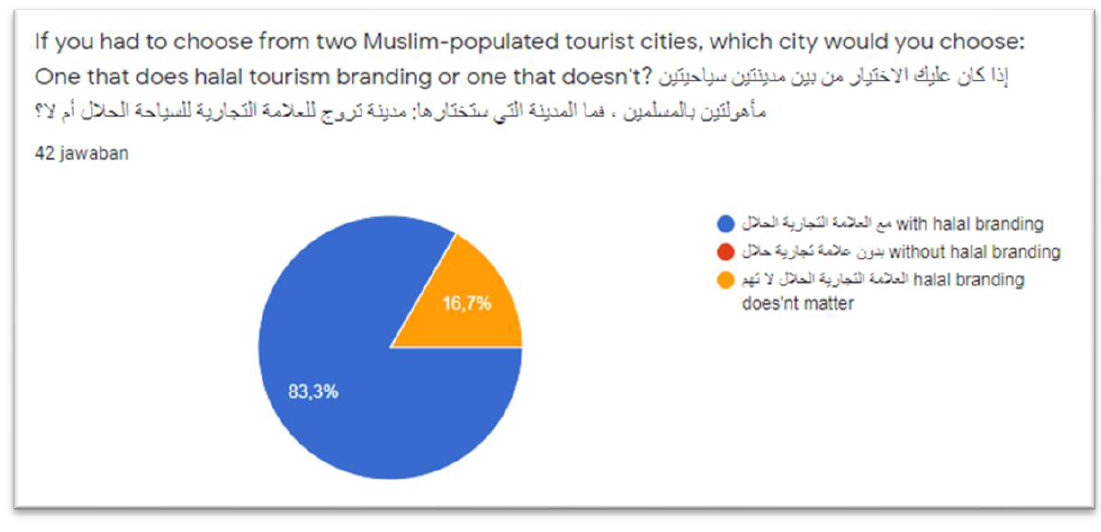
Figure 3. Responses upon the plan or decision of visit based on halal tourism